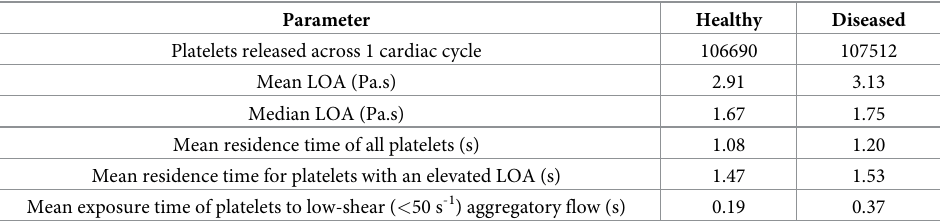
Table 4. Data from platelet tracking from the MKM5 model in the healthy/diseased